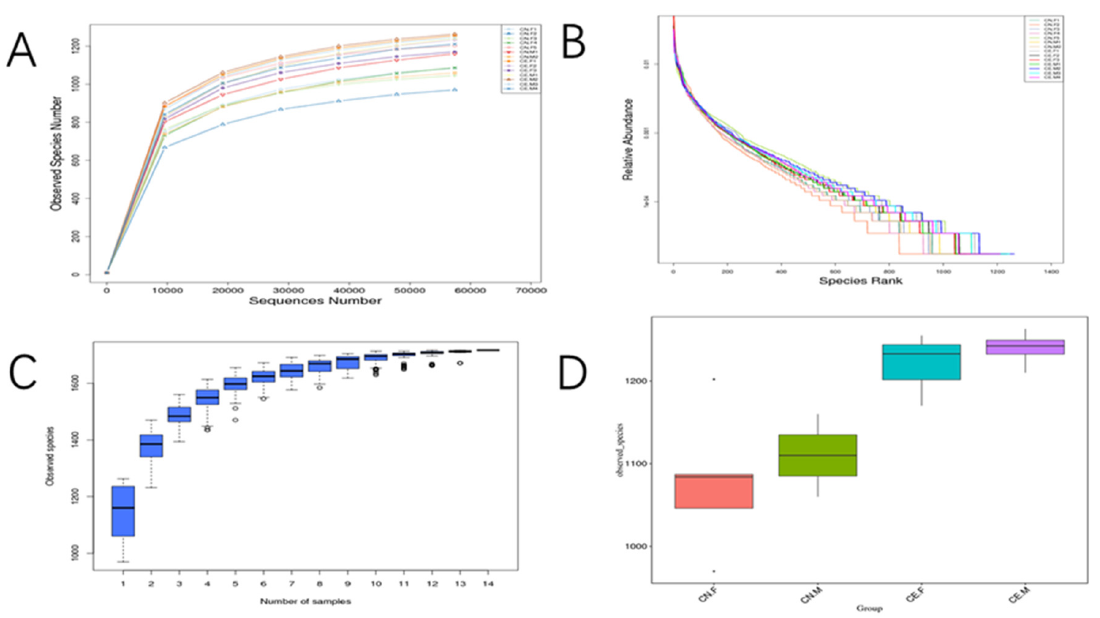
Figure 6. ( A ) The rarefaction curves for the species abundance of the samples. The horizontal axis represents the sequence number, and the vertical axis represents the observed species number. Each curve in the figure represents a sample, presented in a different color. ( B ) Rank abundance curves of the bacterial OTUs derived from each sample. Different samples are represented by curves of different colors. The abscissa is the species rank, and the ordinate is the corresponding relative abundance. ( C ) Species accumulation boxplot. The abscissa represents the sample size and the ordinate represents the number of OTUs after sampling. The results reflect the rate of new OTUs under continuous sampling. ( D ) Box plots of observed species.